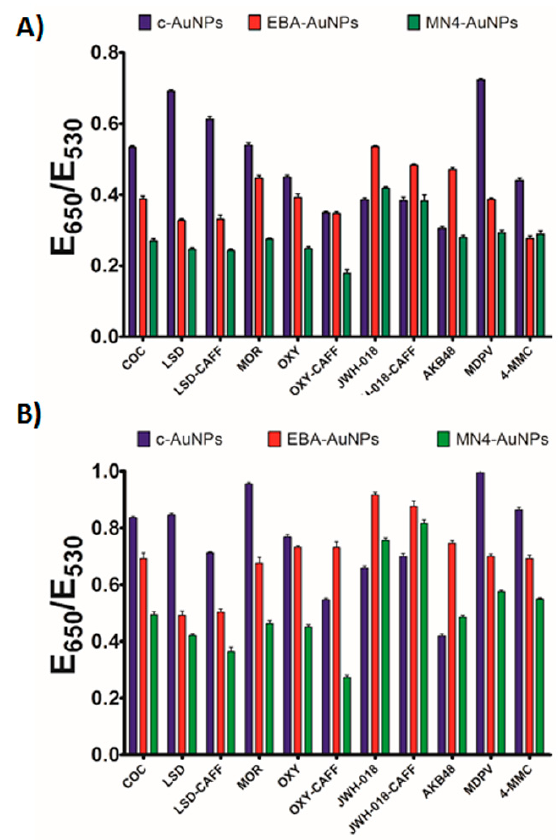
Figure 3. Controlled substances plasmonic fingerprint. The response of the Apt-AuNPs is presented grouped by analyte tested after incubation with NaCl to promote color development for: ( A ) 30 s; ( B ) 5 min.